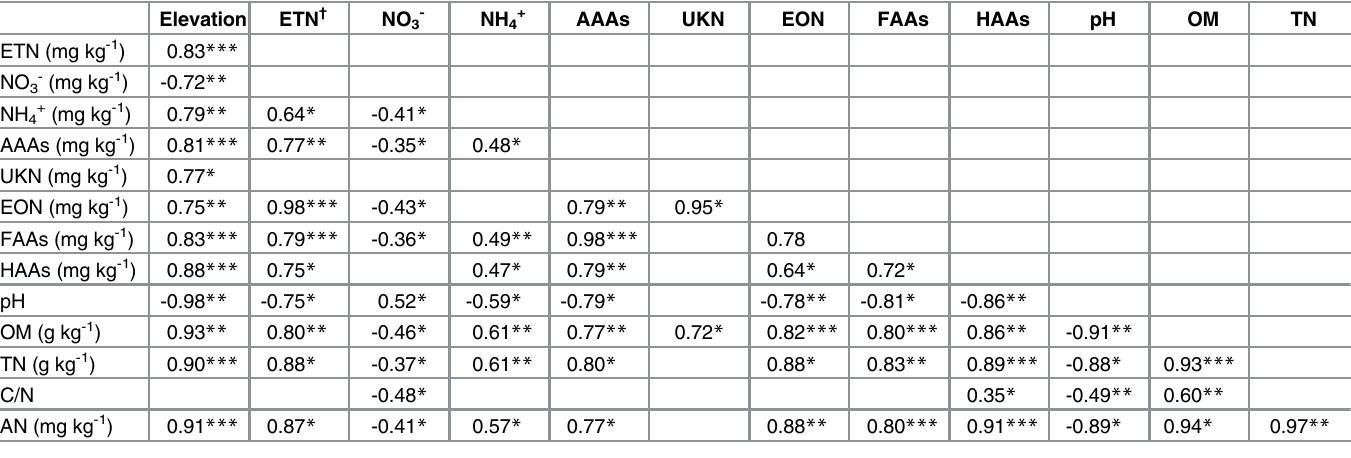
Table 3. Pearson correlations among basic soil properties, inorganic N and amino acid N. Only significant correlations are presented.